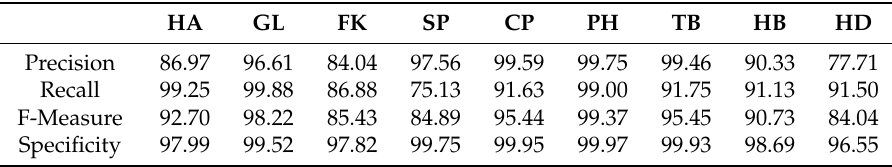
Table A1. Values of precision, recall, F-Measure, specificity of LOSO model SVM FS (all values are expressed in